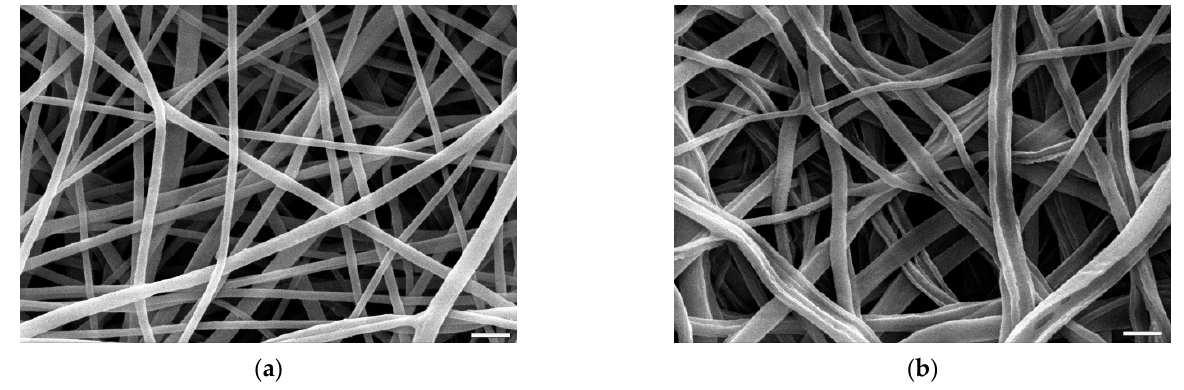
Figure 8. SEM images of control non-crosslinked samples: ( a ) before, ( b ) after biodegradation test. The marker equals 10 µm.